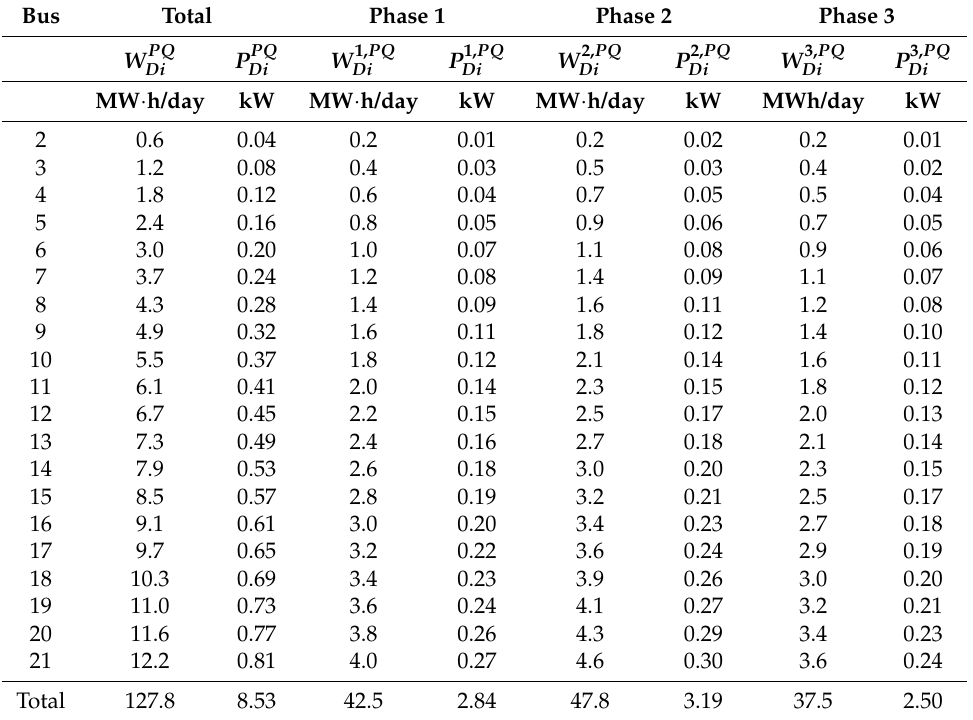
Table 1. Base load: No EV connected, only PQ